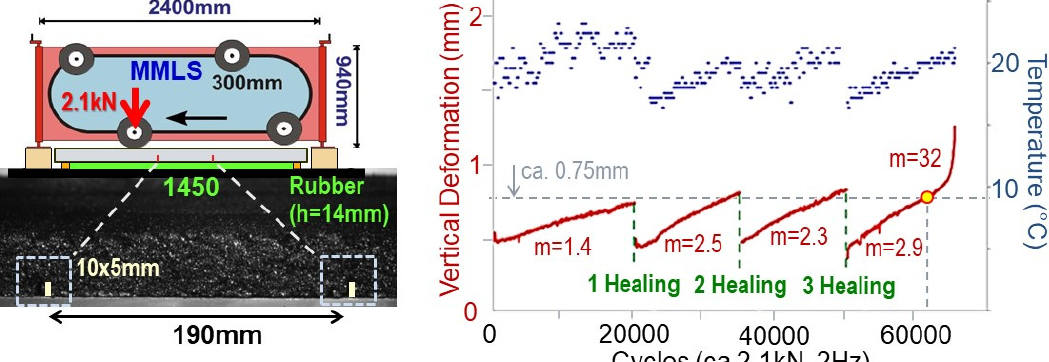
Figure 3. Principle of inductive crack healing and double torsion DIC result.